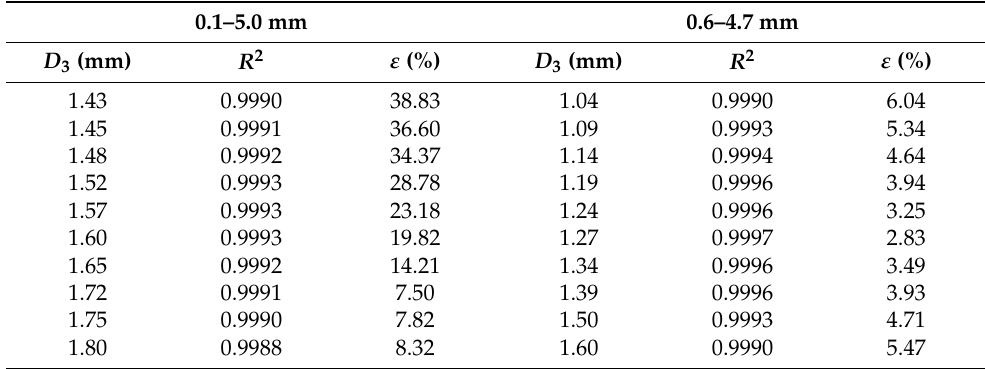
Table 2. Linear regression of the simulation